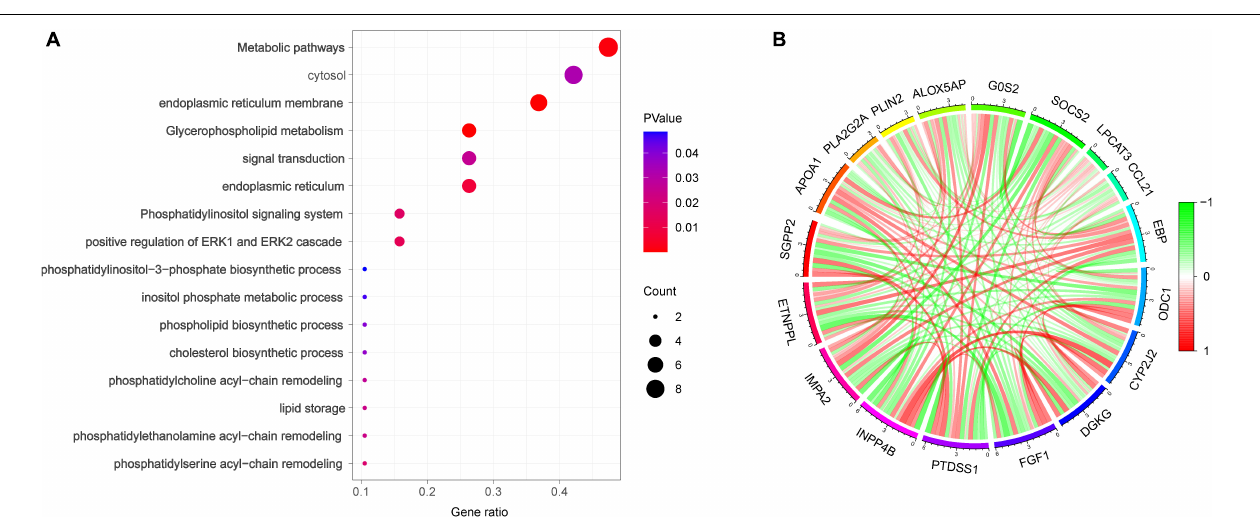
FIGURE 3 | Functional enrichment analysis (A) Bubble plot of enriched GO terms. (B) Spearman correlation analysis of the 18